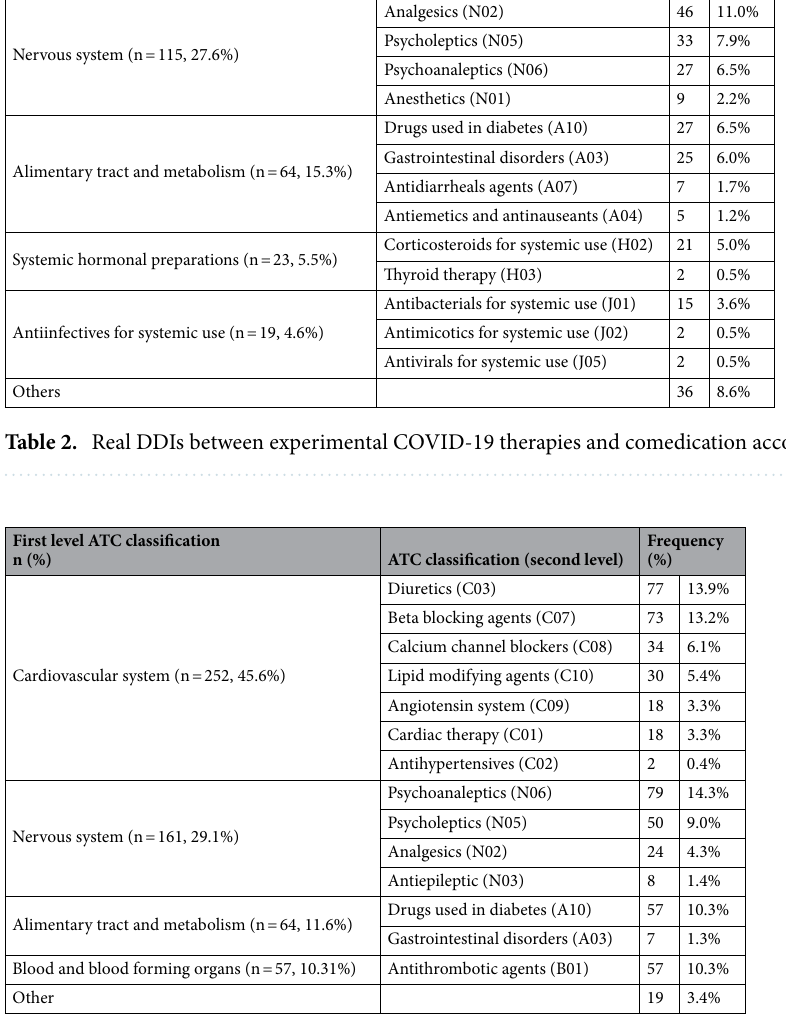
Table 3. Potential DDIs between experimental COVID-19 therapies and comedication according to ATC.